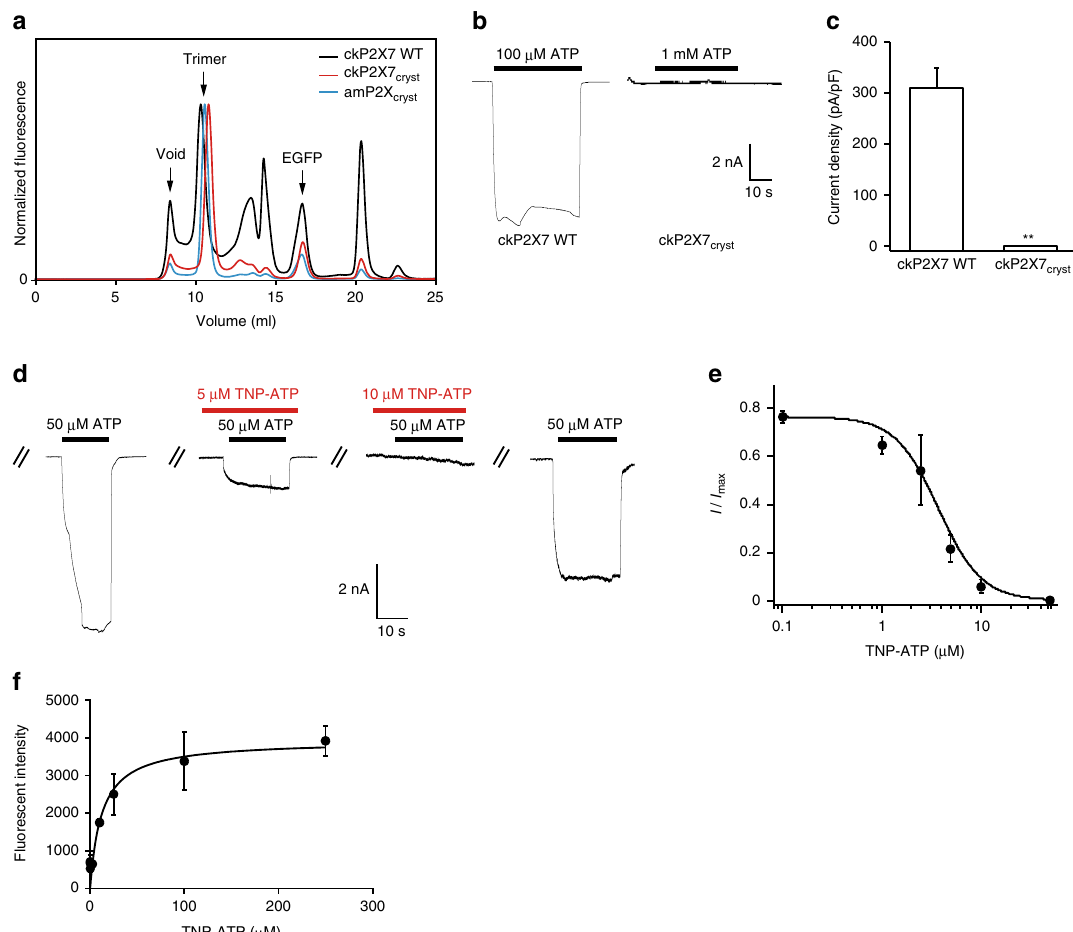
Fig. 1 Functional properties of ckP2X7 and crystallization construct ckP2X7 cryst . a FSEC pro fi les on a Superdex 200 10/300 GL column (GE Healthcare) for the EGFP-fused ckP2X7 WT ( black ), the EGFP-fused ckP2X7 cryst ( red ), and the EGFP-fused amP2X cryst ( cyan ), expressed in HEK293S GnTI − cells. The arrows indicate the estimated elution positions of the void volume, the EGFP-fused P2X (trimer), and the free EGFP. b Representative traces of ATP-evoked currents of ckP2X7 WT and ckP2X7 cryst . c Summarized effect (mean + s.e.m., n = 3 – 15) of the mutation on the ATP current of ckP2X7 cryst . ** p < 0.05 vs. ckP2X7 WT. d Representative traces of the effects of TNP-ATP on the 50 µ M ATP-evoked current of ckP2X7 WT. ATP solution was prepared under Ca 2+ free conditions. e The dose – response curve of TNP-ATP with ckP2X7 WT was fi tted to the Hill equation ( solid line , IC 50 = 3.55 ± 1.1 μ M). Data points are means ± s.e.m. for n = 3. f Measurement of the TNP-ATP binding ability of the ckP2X7 cryst , monitored by the excitation spectrum change of TNP-ATP upon protein binding. Error bars indicate ± s.e.m. for n = 5. The calculated K d for TNP-ATP binding is 12.26 ± 2.64 µ